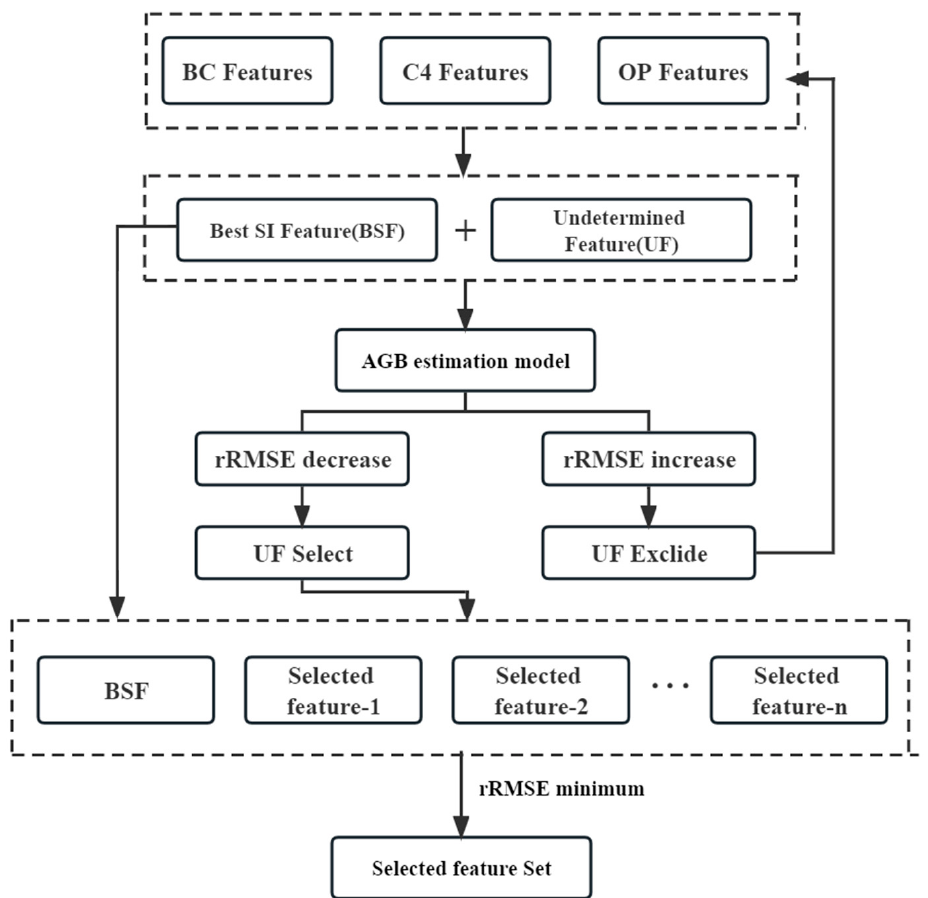
Figure 4. Schematic diagram of SIS feature selection method.